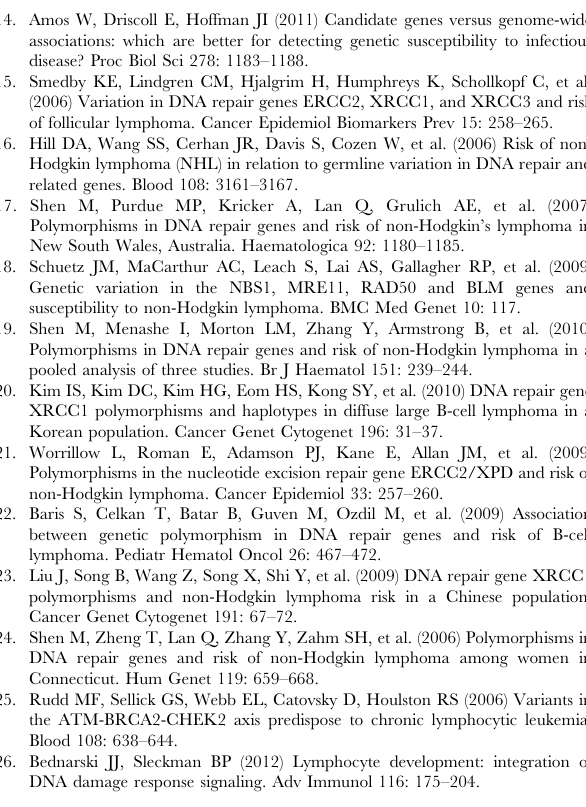
both stage 1 and stage 2 (n= 94). Associations between MRE11A and NBS1 are shaded in grey. Table S7 Pairwise interaction results between NBS1 (rs1805812) and MRE11A (rs607974, rs625245, rs557148, rs10831227) and NHL risk under three different genetic models. Each model was tested for a different SNP x SNP combination between rs1805812 and 4 SNPs tagging MRE11A . Indicated are the different combinations of genotypes used for each respective genetic model. Table S8 Summary of tagging and imputed SNPs in DNA repair genes associated with NHL risk with high predicted functional impact. Functional information was annotated using ANNOVAR, and included data generated from the ENCODE